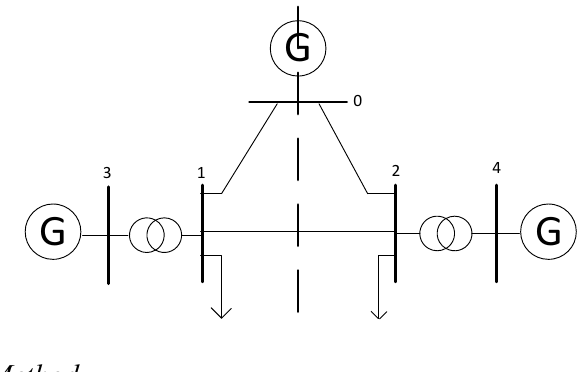
Figure 3. A simple symmetrical system, where the dotted line shows the axis of